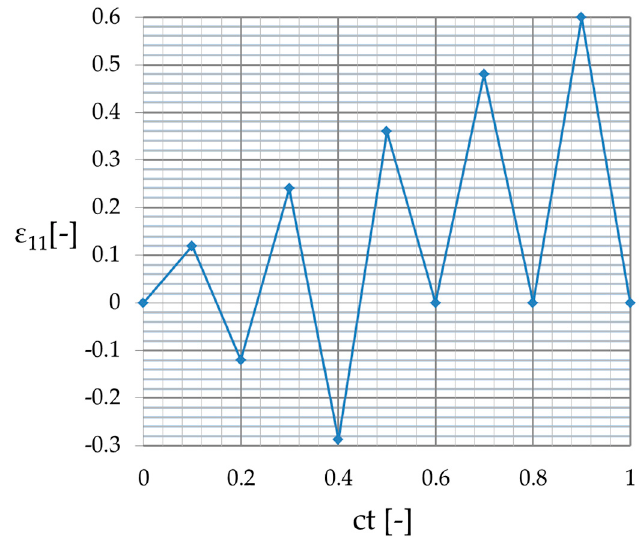
Figure 5. External strain applied on the outer edges of the RVE with respect to computation time 𝑐𝑡 .